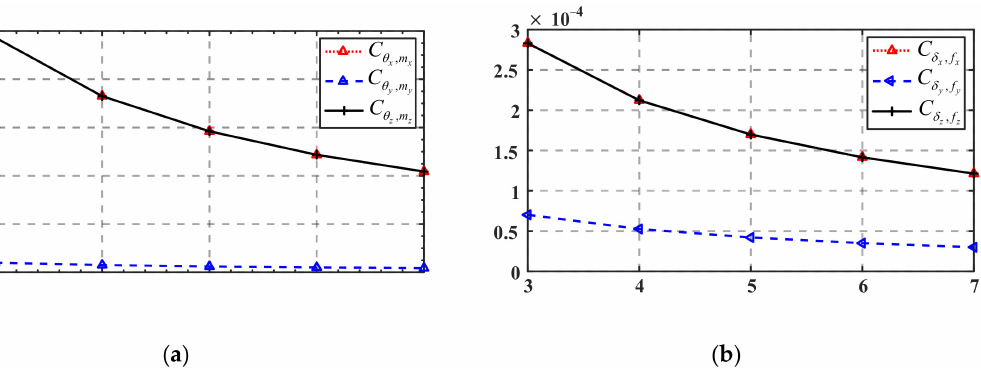
Figure 8. Compliance variation in terms of the number of mechanism branches n : ( a ) C θ ; ( b ) C δ